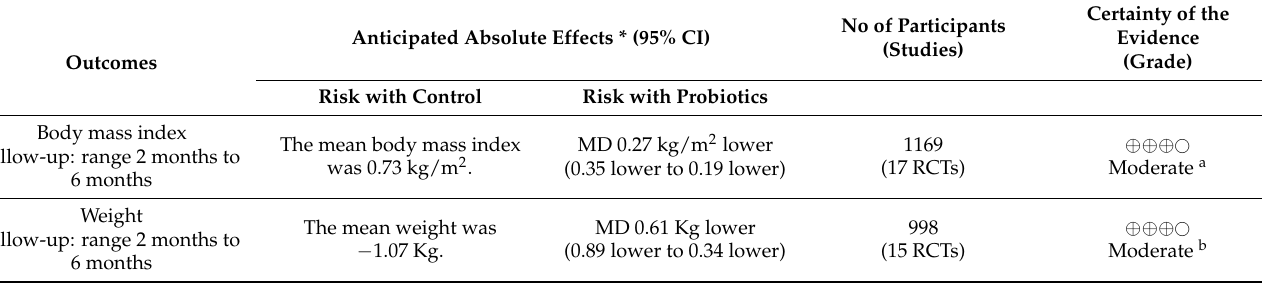
Table 2. GRADE summary of findings